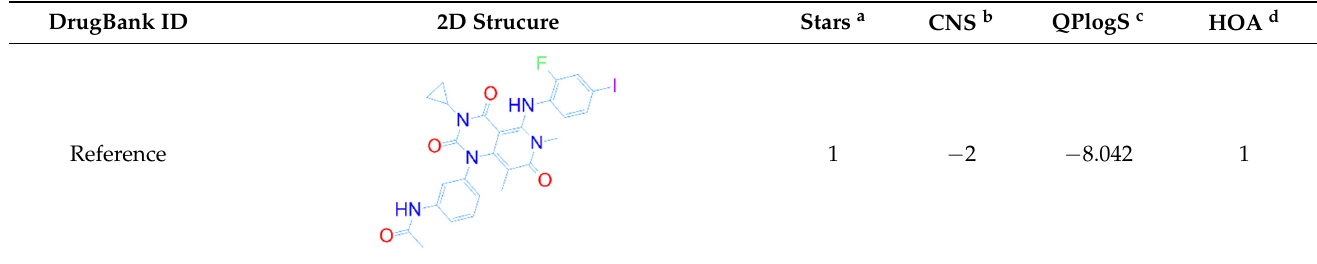
Table 3. 2D structure of hit compounds with their predicted ADME properties.